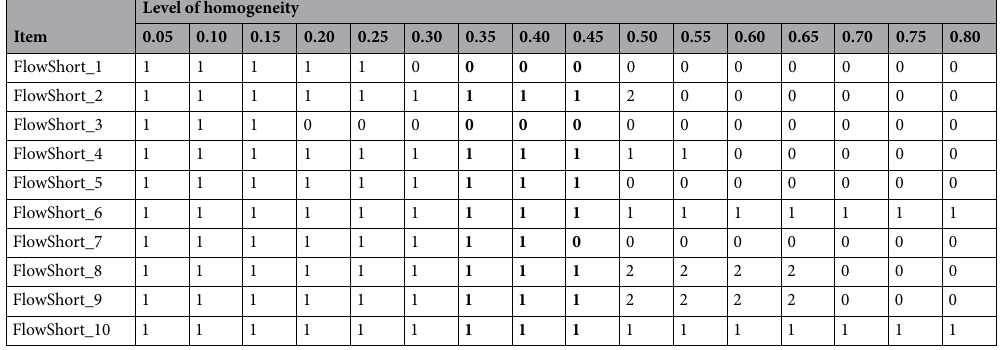
Table 3. Item selection for different levels of homogeneity index thresholds. Bold columns show solutions with acceptable scalability, that retains a theoretically sensible scale structure.